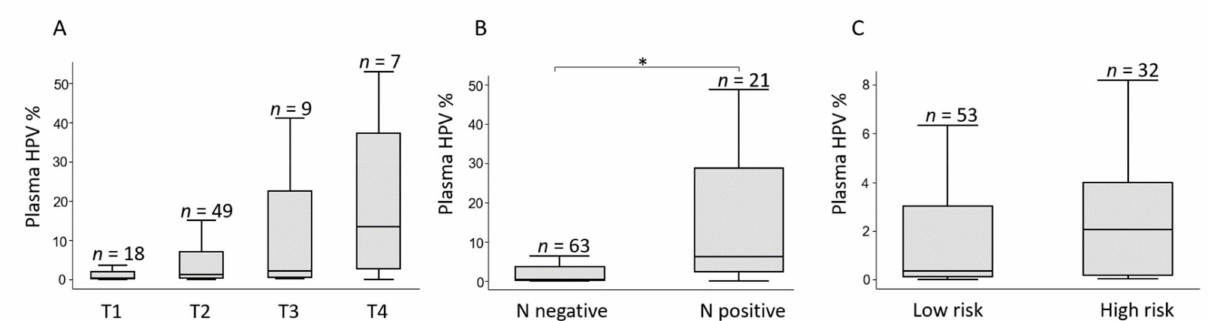
Figure 2. Pre-treatment pHPV levels according to disease stage. Boxplots with median pHPV value in % of total level of circulating free DNA. Lines are ranges. Outliers ( n = 8) were removed. ( A ) The pHPV level increases non-significantly with increasing tumor (T) stage. ( B ) Comparison of pHPV between lymph node negative (N negative) and lymph node positive (N positive) tumors. ( C ) A higher level of pHPV is detected for T2-T3 and/or N positive tumors (high-risk) compared to T1-T2, N negative tumors (low risk). Statistical significance (*) were calculated using Wilcoxon–Mann–Whitney test.